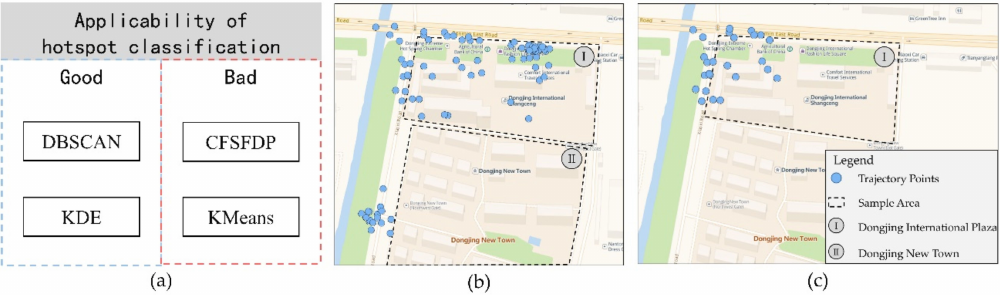
Figure 8. Applicability of hotspot classification: ( a ) Application of hotspot classification; ( b ) Multiple AOIs are merged; ( c ) Single AOI is